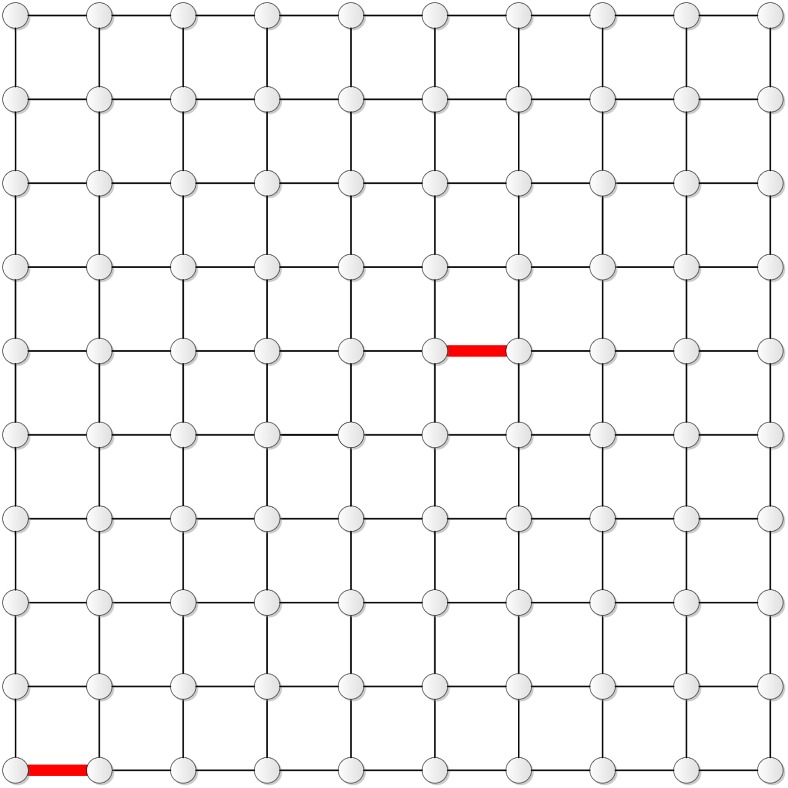
The two edges in T10.